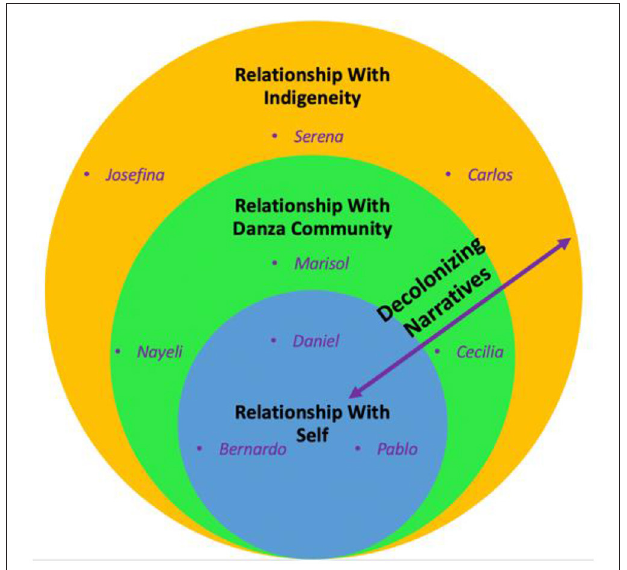
FIGURE 2 | Decolonizing narratives of the health analytic framework: placement of participant